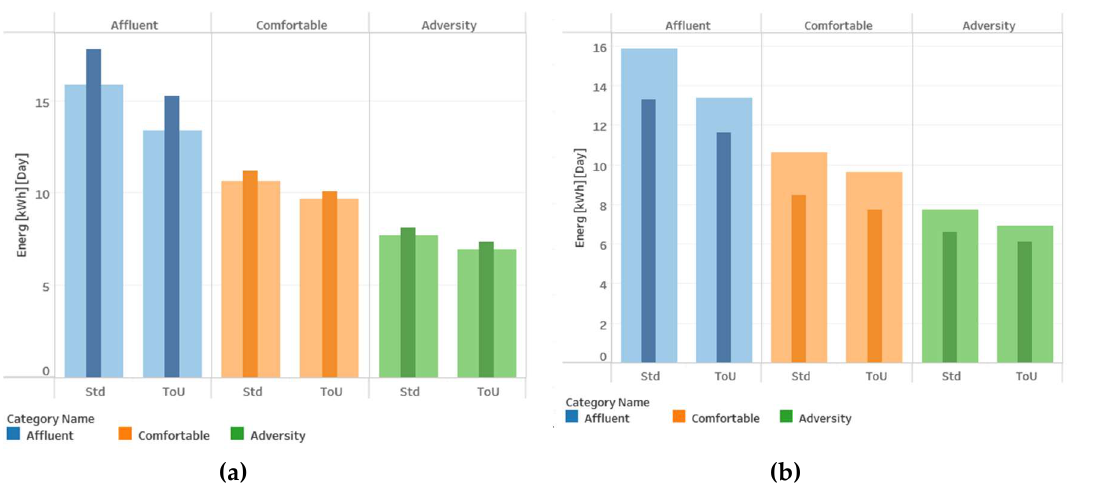
Figure 8. Energy consumption on holiday days (thin) versus workdays (thick): ( a ) year 2013 consumption, ( b ) August 2013 consumption.